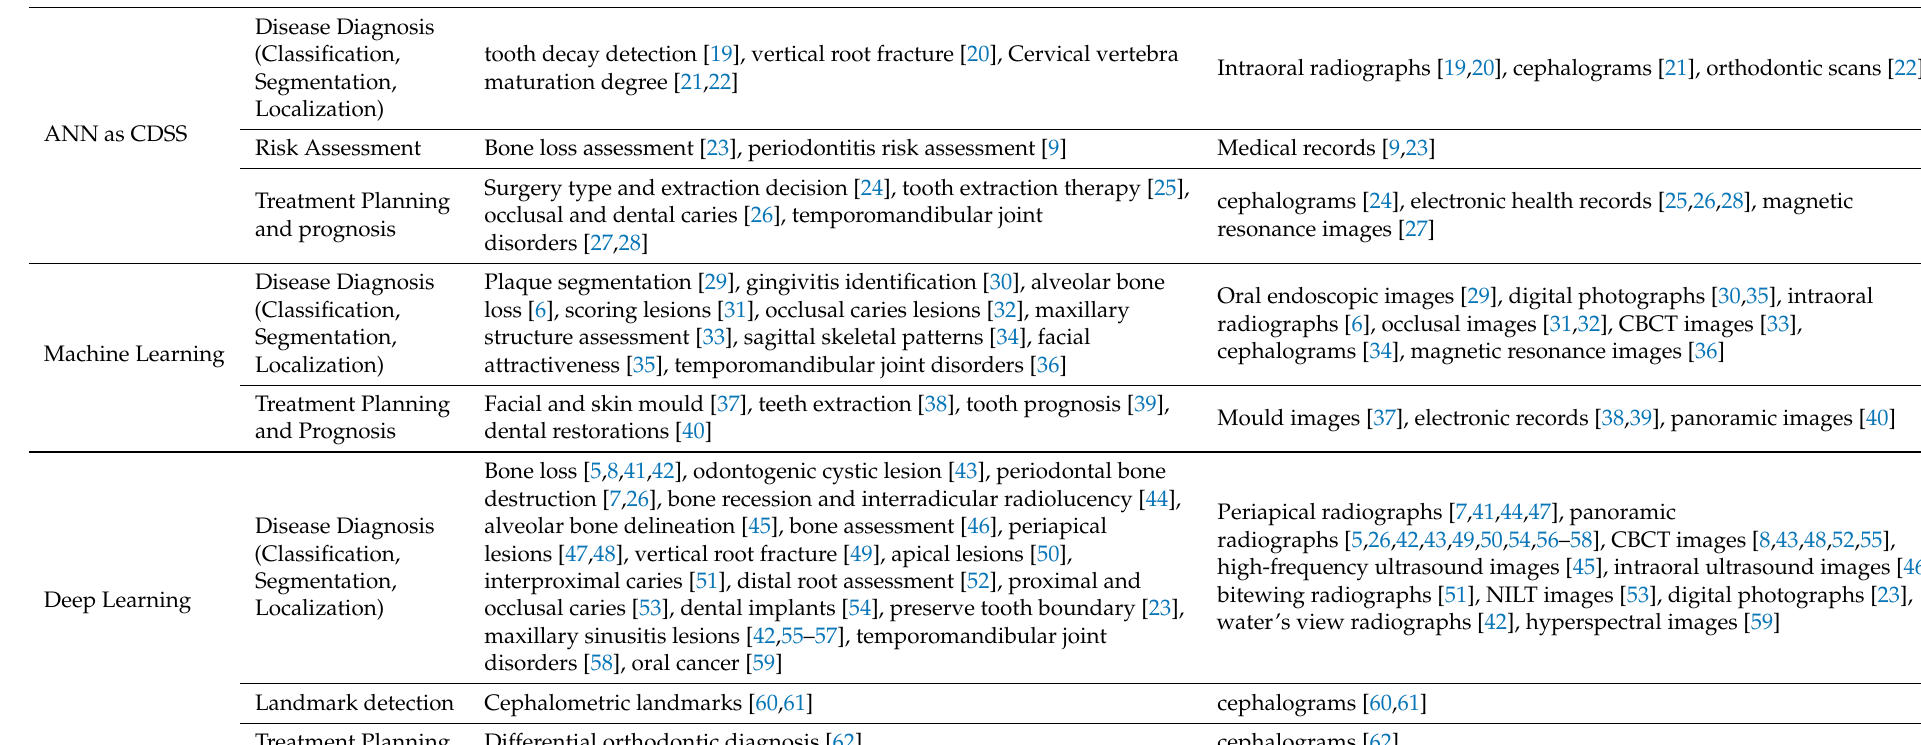
Table 2. Summary of input features used for different diagnostic